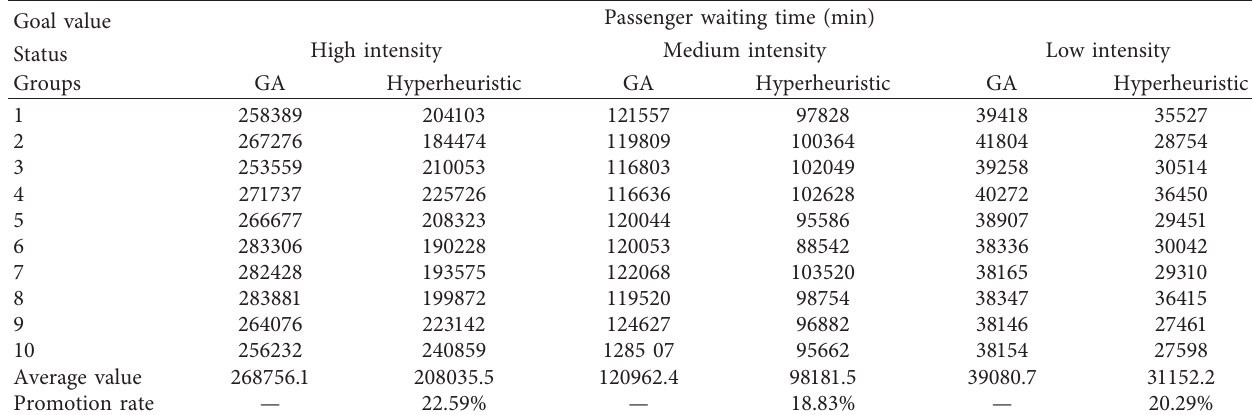
Table 5: Results of GA and hyperheuristic algorithm under decreasing passenger